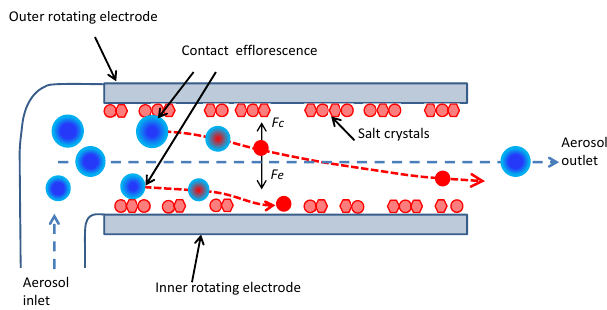
Figure 5. Schematic representation of the metastable microdroplets efflorescence when coming into contact with salt crystals deposited on the electrode surface. Explanation and designations are given in the